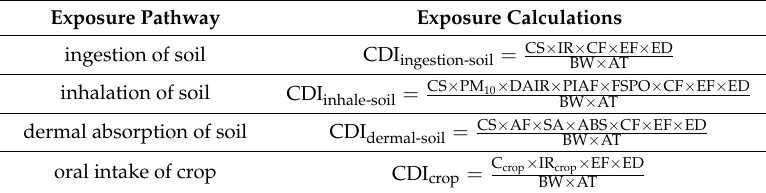
Table 1. Equations of daily intake dose via various exposure